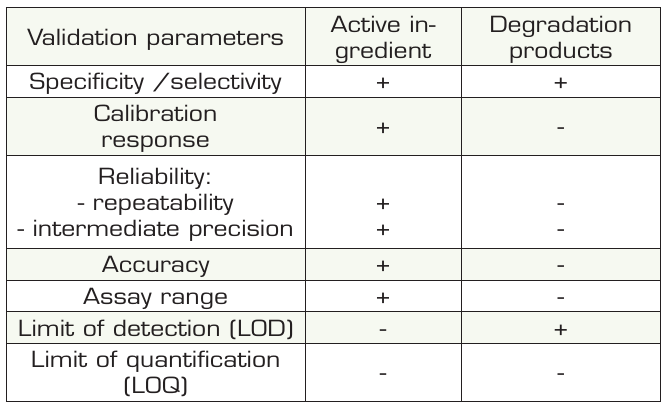
Table 5: validation parameters of an analytical method for use in stability studies To obtain a precise definition of these analytical parameters, consult Appendix 1 .